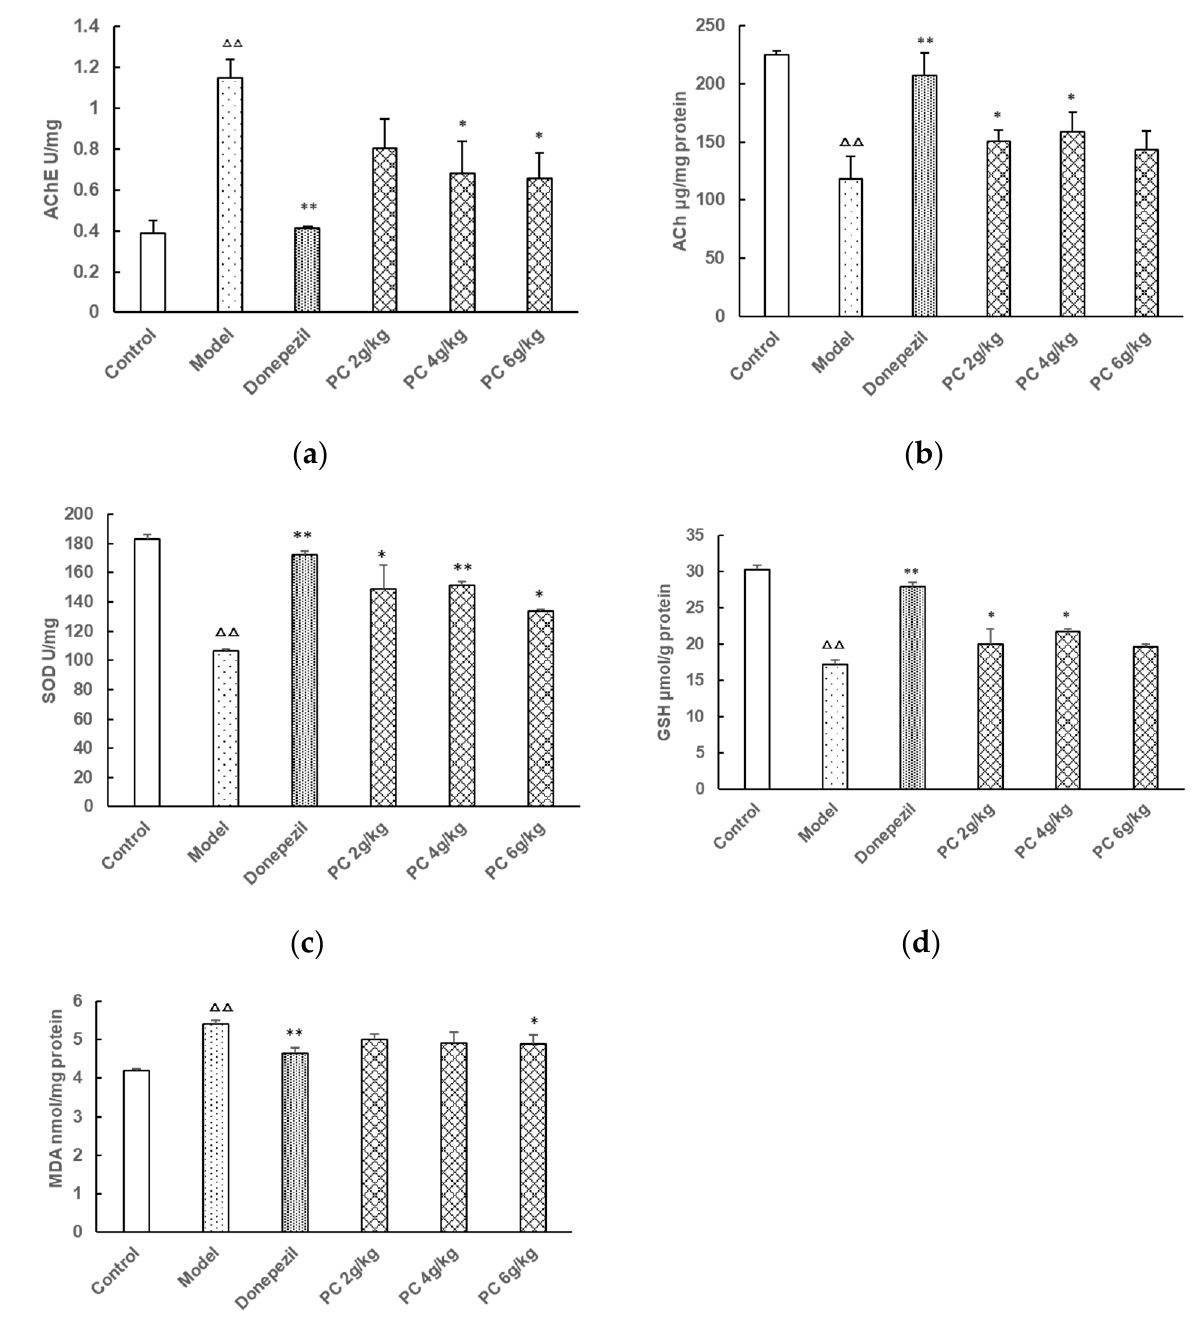
Figure 5. Levels of AChE, ACh, SOD, GSH, and MDA in the brain tissue of mice. (day 29). ( a ) AChE, ( b ) ACh, ( c ) SOD, ( d ) GSH, and ( e ) MDA. After the probe trails (day 29), the tested animals were sacrificed by exposure to CO 2 and cervical dislocation, then quickly separated the cerebral cortex and hippocampus tissue on ice, rinsed with precooled normal saline, cleaned with a filter paper and weighted. A 10% homogenate was prepared by adding 9 volumes of normal saline into the brain tissue sample and centrifuged at 1000× g for 20 min at 4 °C. The supernatant was maintained for determination of the levels of AChE, ACh, SOD, GSH, and MDA using assay kits. The data represents the mean ± SD. (vs. control: ∆∆ , p < 0.01; vs. model: *, p < 0.05, **, p < 0.01 ) .